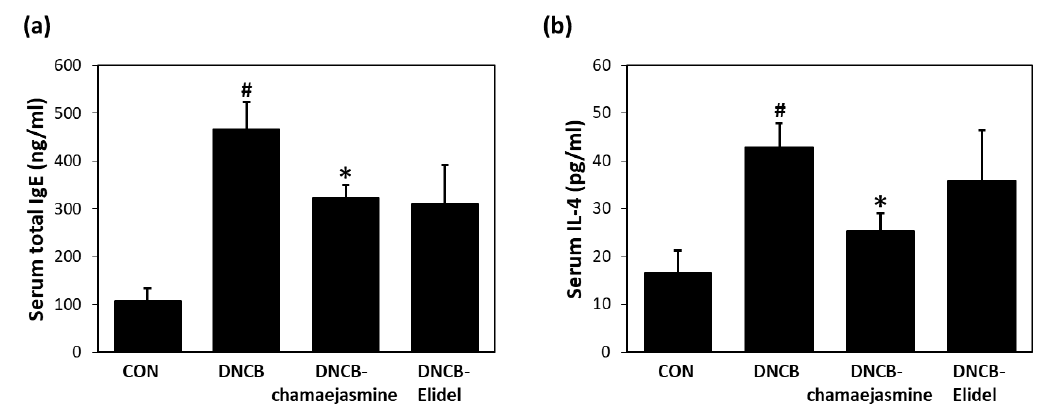
Figure 6. Effects of chamaejasmine on serum IgE and IL-4 levels in DNCB-sensitized SKH-1 hairless mice. ( a ) Serum total IgE levels, ( b ) serum total IL-4 levels. Serum samples were collected and tested for IgE and IL-4 concentrations on the last day of the experiment (experimental day 21). Results are expressed as the means ± SEMs ( n = 7) of two independent experiments. # p < 0.05 vs. the CON group; * p < 0.05 vs. the DNCB group. EtOH extract of Wikstroemia dolichantha , CON: vehicle control group, DNCB: DNCB-treated control group, DNCB-chamaejasmine: DNCB and 0.5% chamaejasmine-treated group, DNCB-Elidel: DNCB and 1% pimecrolimus cream-treated group.